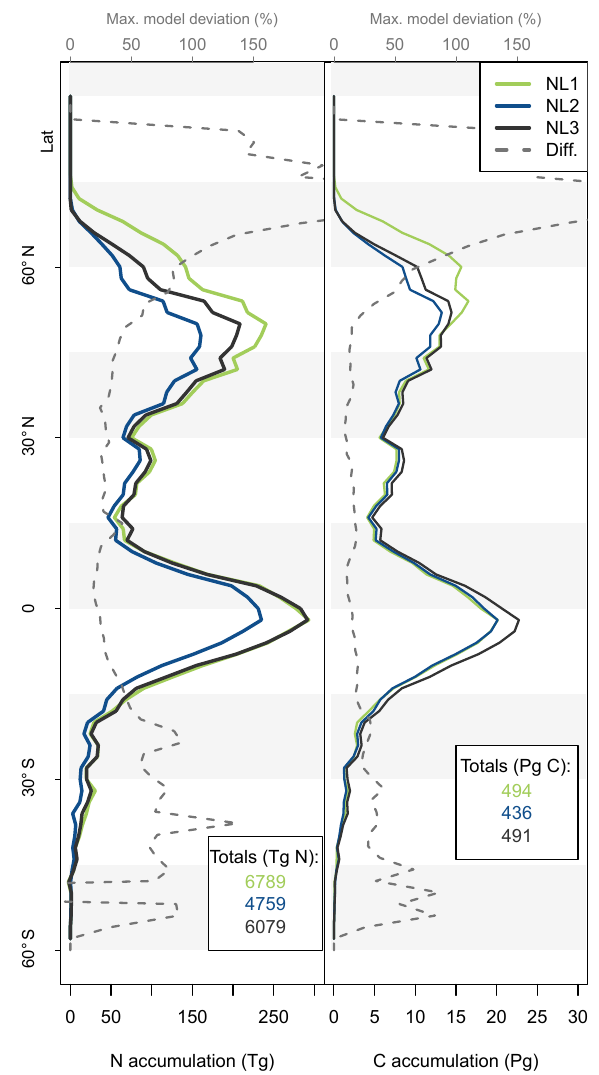
Figure A3. Nitrogen (N, left) and carbon (C, right) accumulation during global simulations of elevated atmospheric CO 2 concentrations (eCO 2 ) using three different N loss algorithms between 1850 (285ppmCO 2 ) and 2100 (936ppmCO 2 ), depicted per 2 ◦ latitudinal band and as global totals (coloured numbers). “Diff.” shows the respective maximum deviation between the three models as the percentage of the three-model mean. The global total values corresponded to average yearly accumulations of 27.2, 19.0, and 24.3TgNyr − 1 (NL1, NL2, and NL3) and 2.0, 1.7, and 2.0PgCyr − 1 . The difference to Fig. 5 is the usage of an O–CN terrestrial biosphere model version that